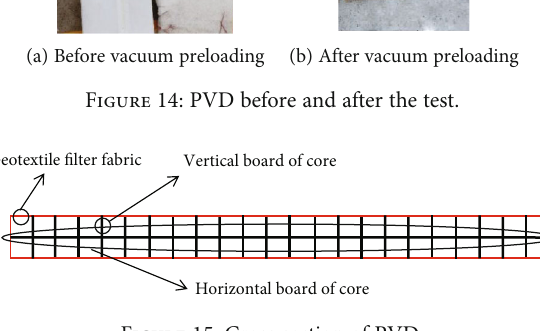
Figure 15: Cross section of